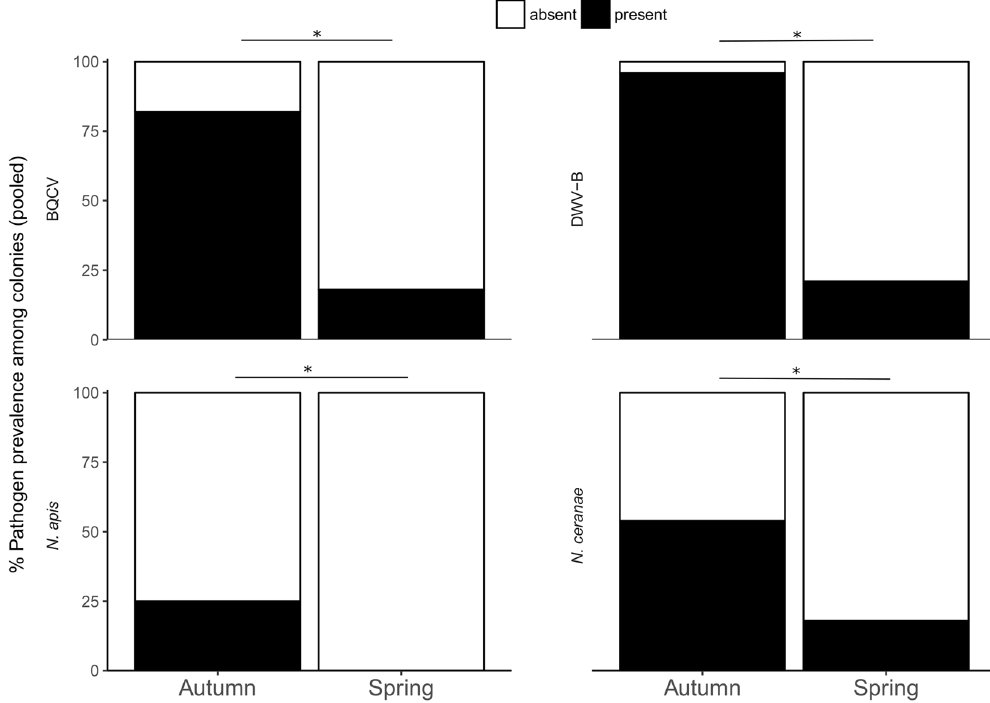
Figure 1. Proportional overwinter change in pathogen prevalence among colonies (qPCR screen of pooled worker samples, N = 30 bees per colony). Black = pathogen present, white = pathogen absent. * Significant comparisons: paired McNemar’s χ 2 test p < 0.05.